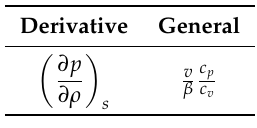
Table A5. Constant